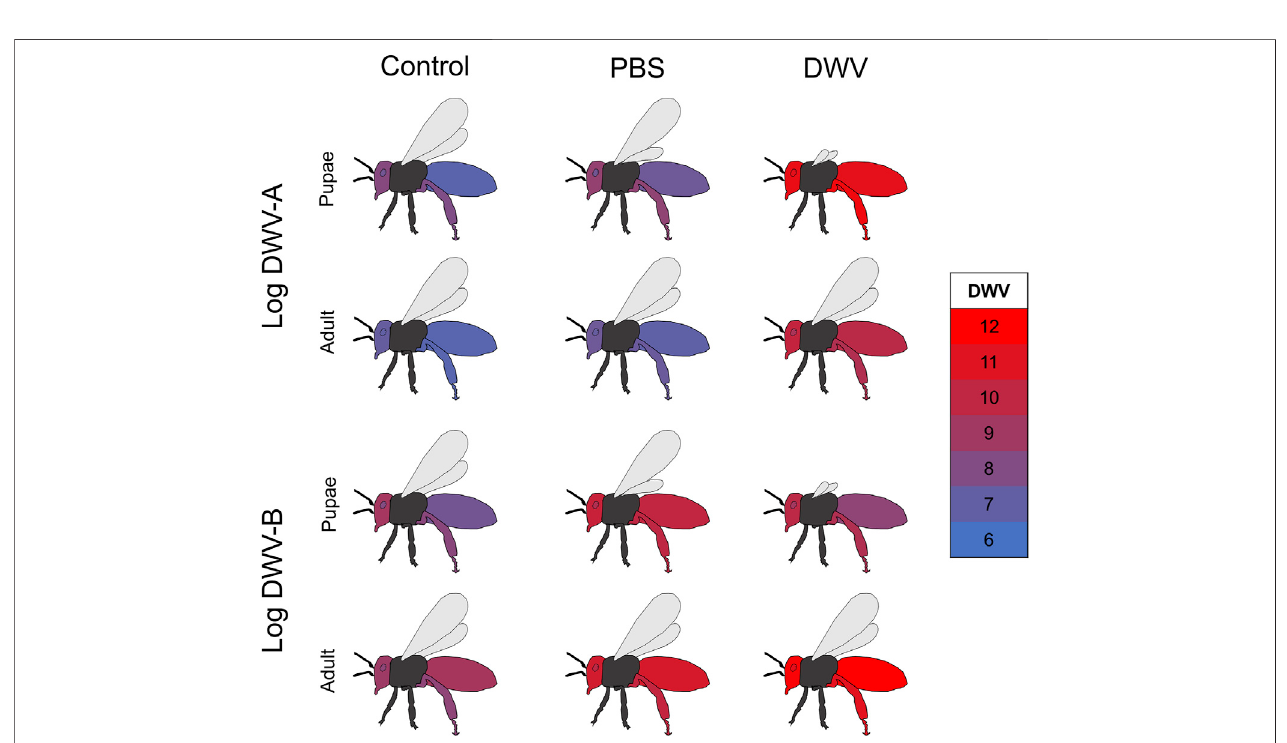
FIGURE4| ComparisonofDWVdisseminationintreatedpupaeandadults.Meanlog-transformedDWV-AandDWV-Bvalues(colorvaluesscaledforoverallDWV levels) in each sampled tissue type (abdomen, head, hypopharyngeal gland, and rear leg) for each treatment (uninjected control, PBS injection, and DWV injection) overlappingbetweentreatedpupaeandtreatednewlyemergedadultexperiments.Thepupaeexperimentrepresentsdatadescribedinthismanuscript(beesinjectedas white-eyed pupae but sampled upon adult emergence about 7 – 8 days post-treatment), while the adult data represent samples of injected newly emerged adults collected 7 days post treatment Supplementary Figure S2 for the comparison of DWV for the combination of stock, treatment, and